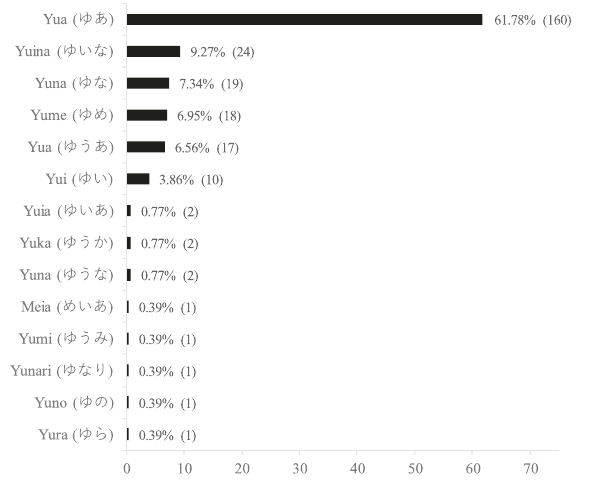
Fig. 5 Variations in readings of the name 結 愛 . Scores indicate relative frequencies of each reading among the sample ( n = 259). Scores in parentheses indicate the absolute frequencies of each reading.